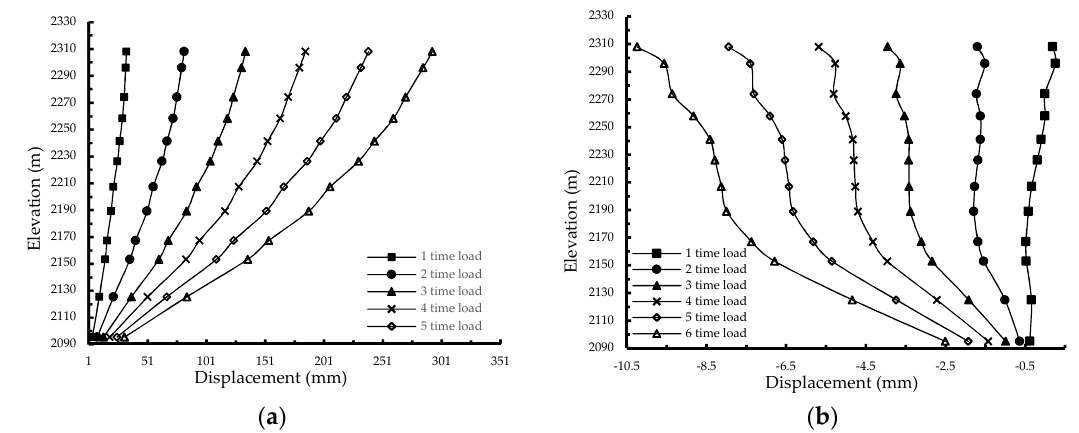
Figure 12. Crown displacement under various analysis cases 1 to 6. ( a ) Crown displacement along river direction; ( b ) crown displacement cross river direction.